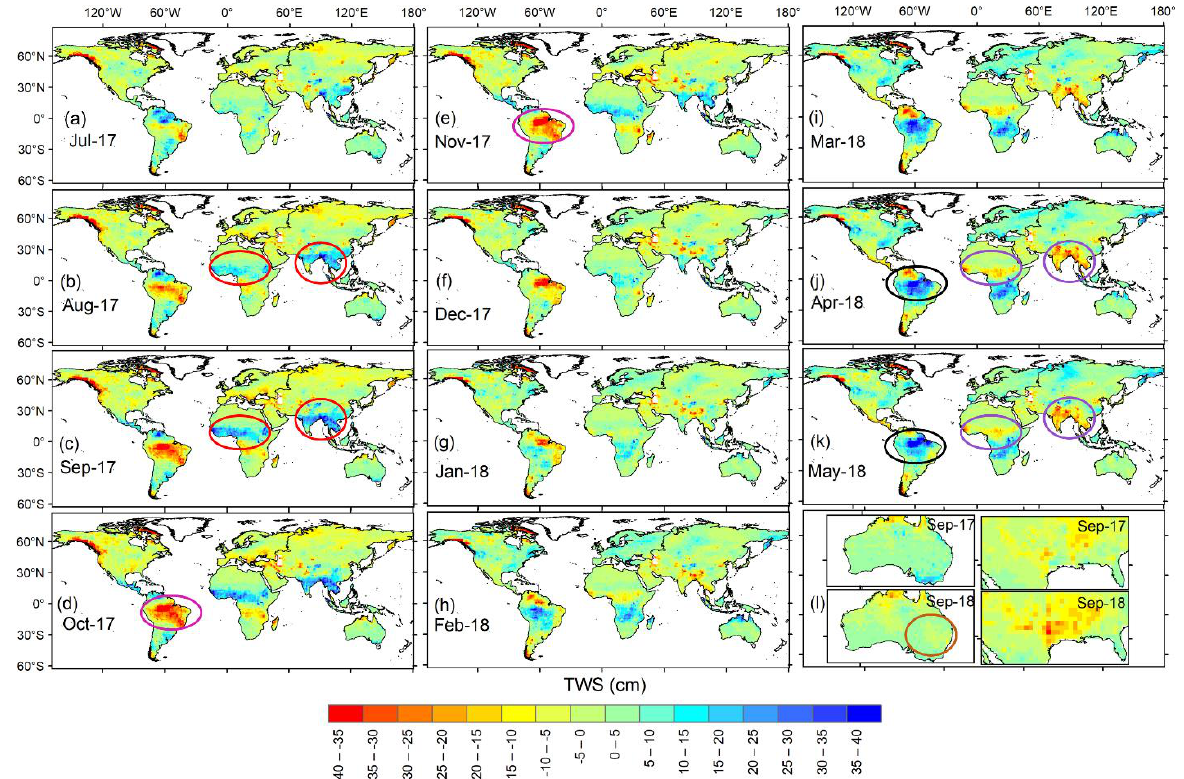
Figure 11. Global monthly (August 2017–May 2018; ( a – k )) grid-scale reconstructed TWS GRACE data for the gap period between GRACE and GRACE-FO missions. The circles depict the regions where the reconstructed TWS GRACE captures the strong seasonal variations and extreme events [i.e., August– September high (red), April–May low (purple), April–May high (black), and October–November